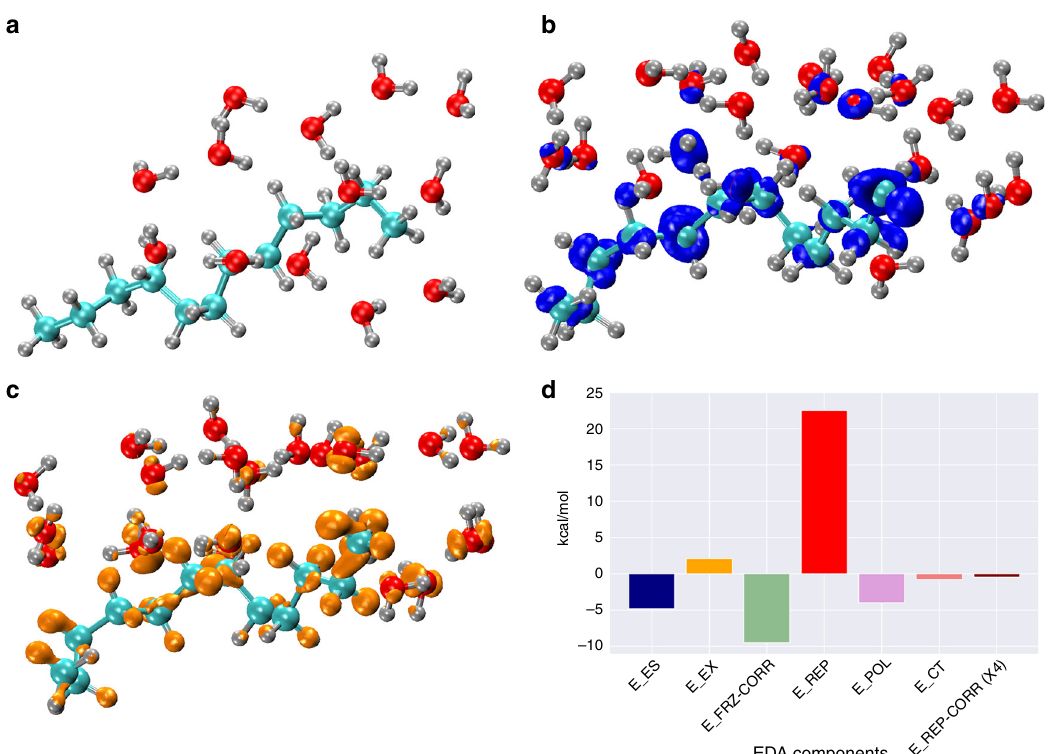
Fig. 7 Water/oil clusters energy decomposition analysis. Sample representation of the clusters considered for the EDA calculations a . The polarization (blue) and charge transfer (orange) electron density difference for the same sample oil – water cluster are highlighted, respectively, in b and c . The average energy component contributions calculated via EDA analysis for the 60 oil – water clusters are reported in d . The acronyms of the different components are: E is the Electrostatic Energy, E is the Frozen Exchange Energy, E is the Frozen Correlation, E is the Pauli Repulsion Energy, E is the (Stoll ES EX FRZ (cid:1) CORR REP POL SCF-MI) Polarization Energy, E is the Charge Transfer Energy and E is the Repulsion CT REP (cid:1) CORR